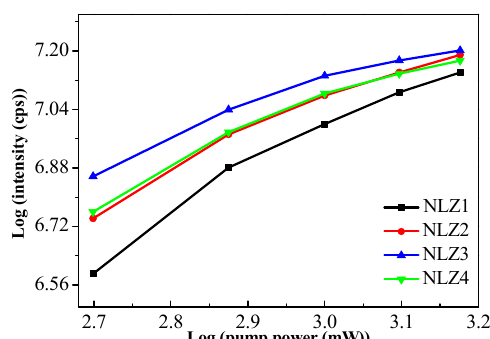
Fig. 4 Energy level diagram of Er 3+ and Yb 3+ in NLZ glass and possible mechanisms.